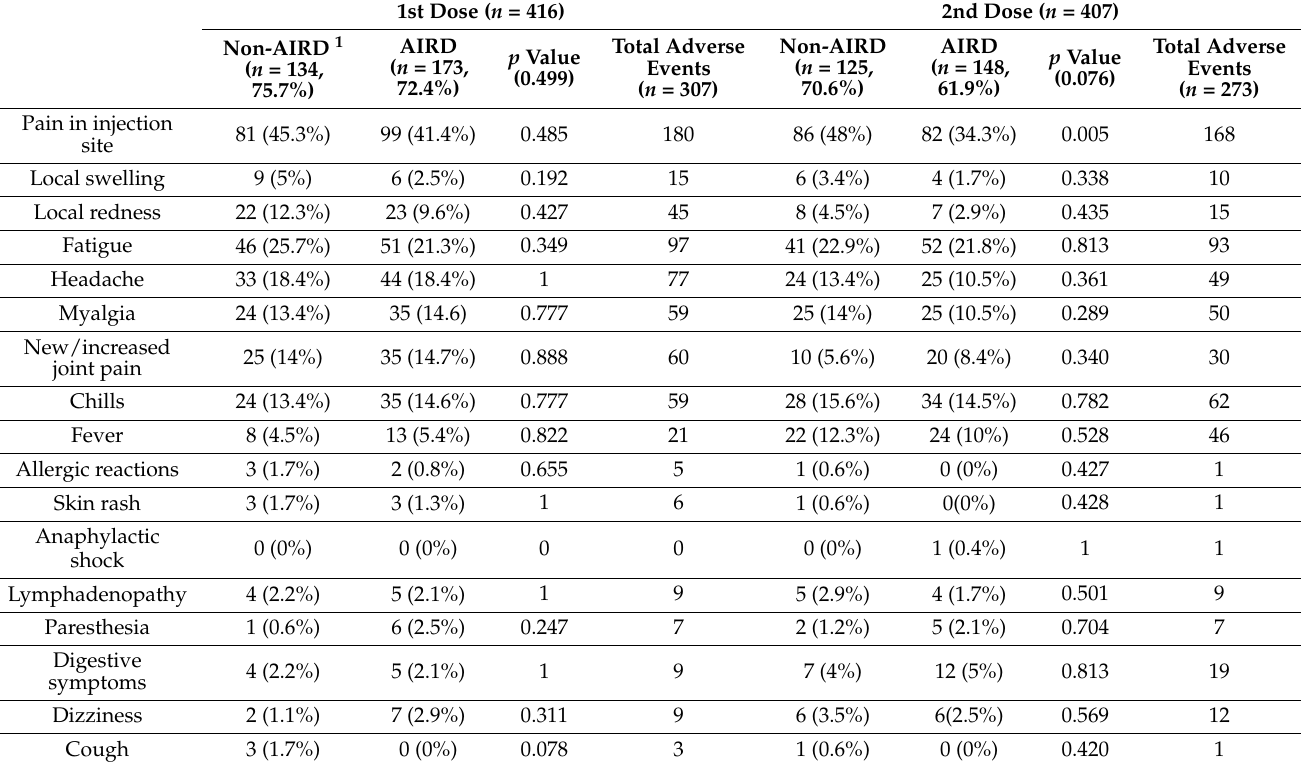
Table 2. Top symptoms reported after the 1st and 2nd COVID-19 vaccine